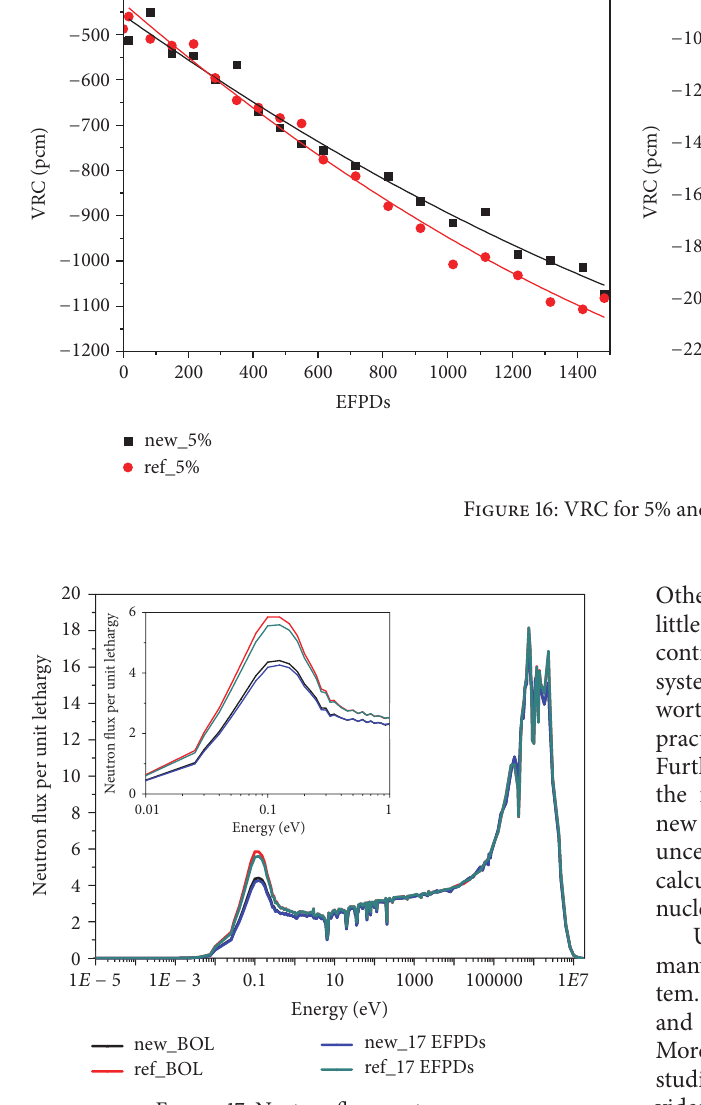
Figure 17: Neutron flux